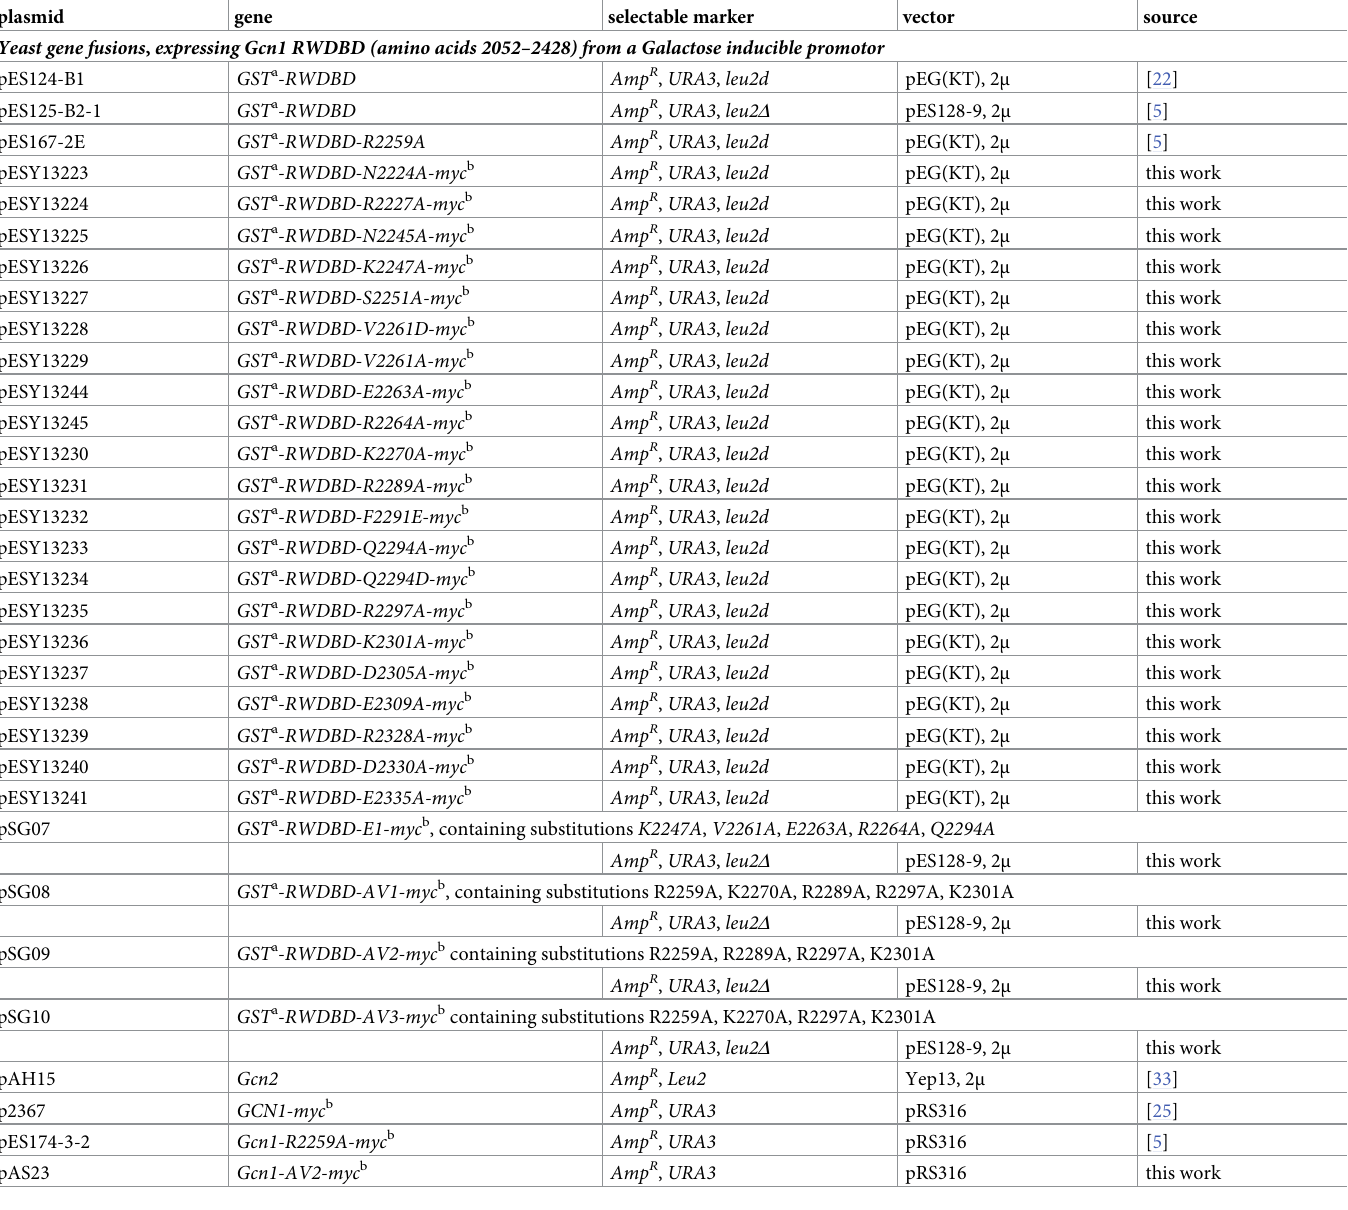
Table 2. Plasmids used in this